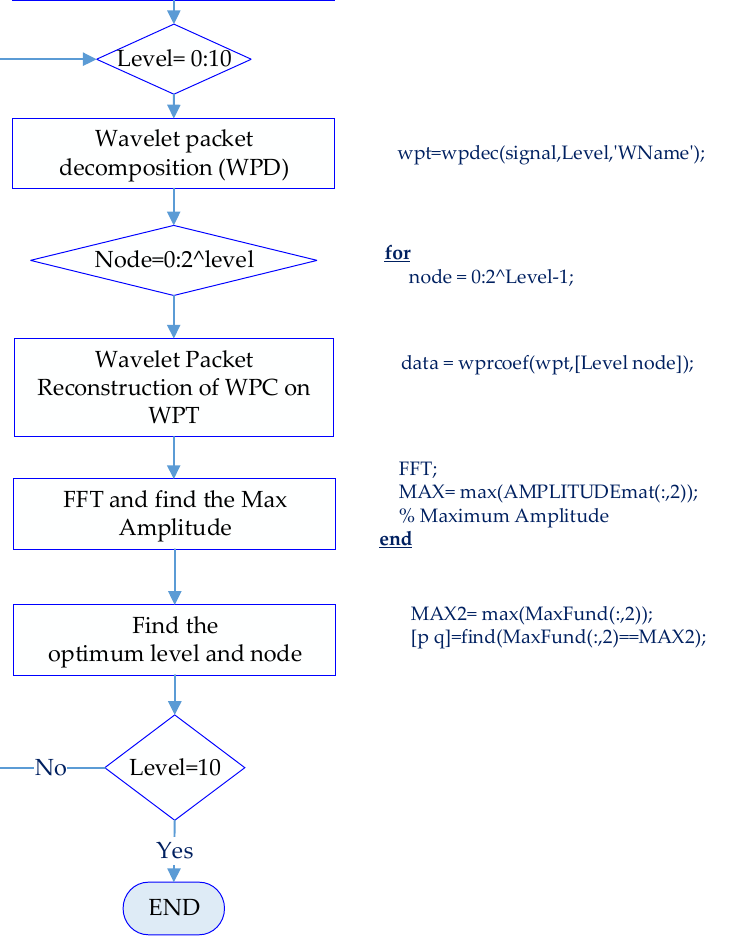
Figure 5. Wavelet packet signature analysis (WPSA)-based algorithm.